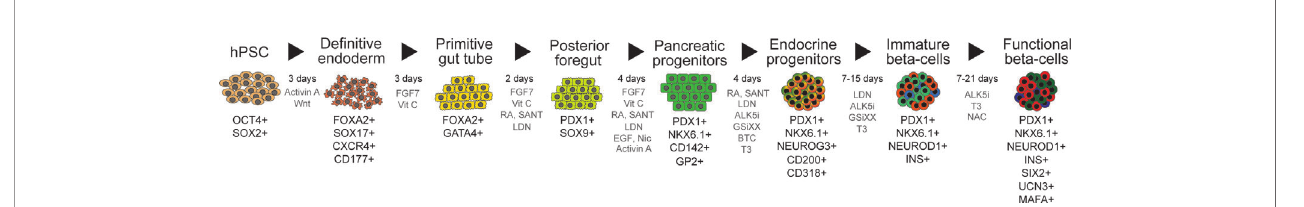
FIGURE 2 | Multistage differentiation protocol to generate functional islet cells from human pluripotent stem cells. Current islet cell differentiation protocols mimic pancreatic developmental stages. Here we represent the commonly used stages [based on (121)], with their usual duration in days, together with cell markers used for the characterization of the differentiated cells (black text) and the cocktails of signaling molecules utilized to induce differentiation (gray text; FGF7, fi broblast growth factor 7; VitC, vitamin C, ascorbic acid; RA, retinoic acid; SANT, SANT-1, a sonic hedgehog signaling inhibitor; LDN, LDN-193189, a BMP inhibitor; EGF, epidermal growth factor; Nic, nicotinamide; ALK5i, a TGF-beta inhibitor; GSiXX, gamma secretase inhibitor used to inhibit Notch signaling; BTC, betacellulin; T3, triiodothyronine; NAC,